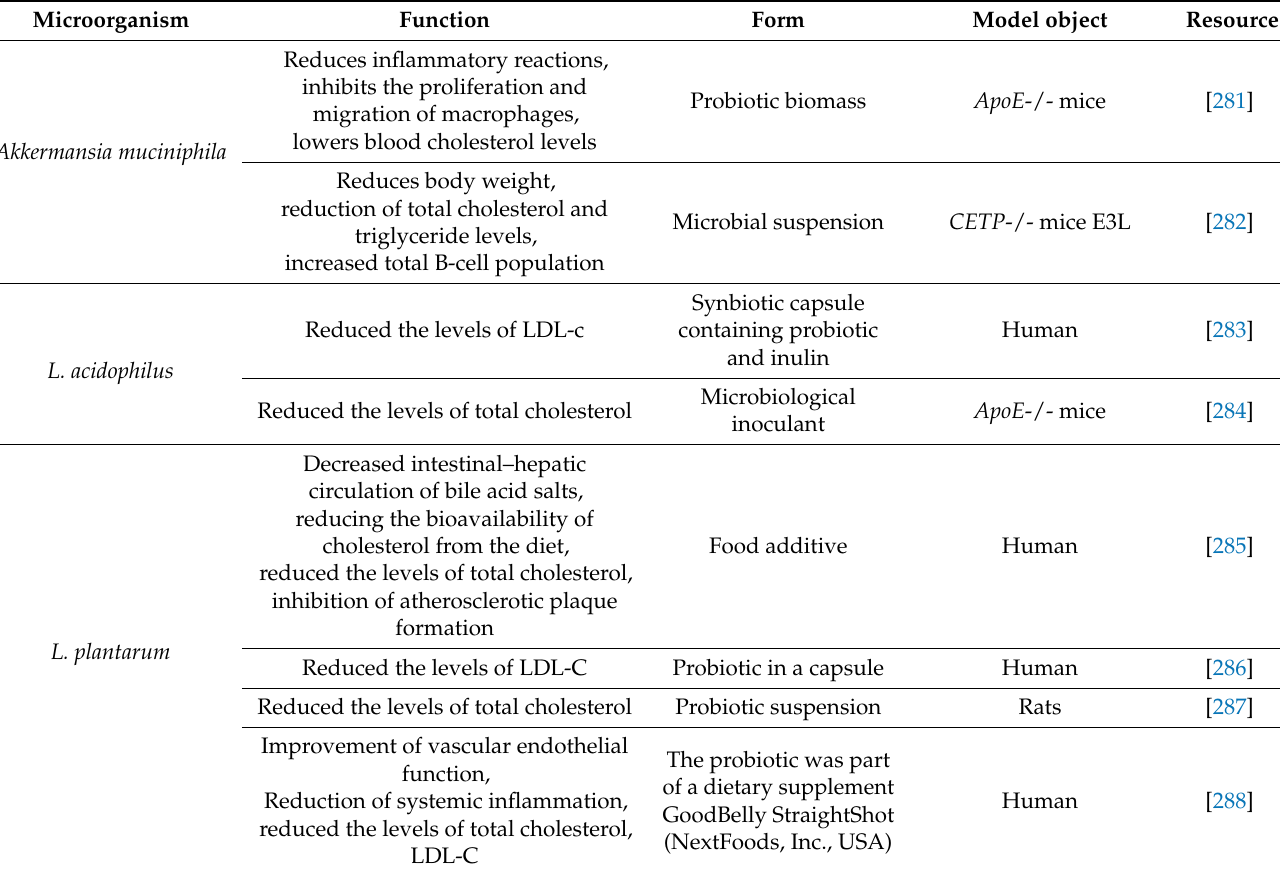
Table 7. List of probiotics consisting of a number of strains that normalize the work of the gastroin- testinal microflora and are used as an anti-atherosclerotic